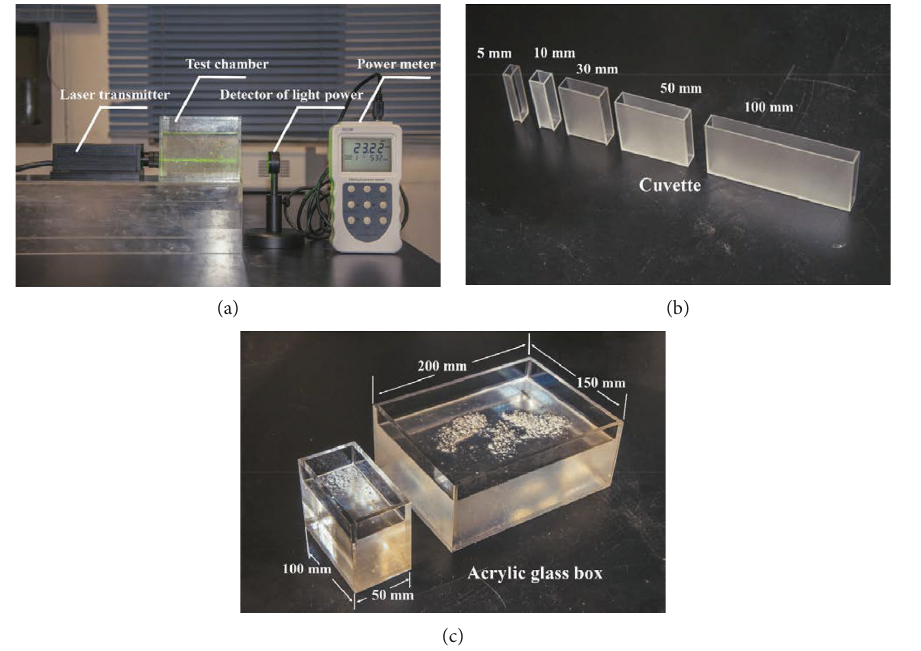
Figure 2: Layout of the experimental apparatus and test